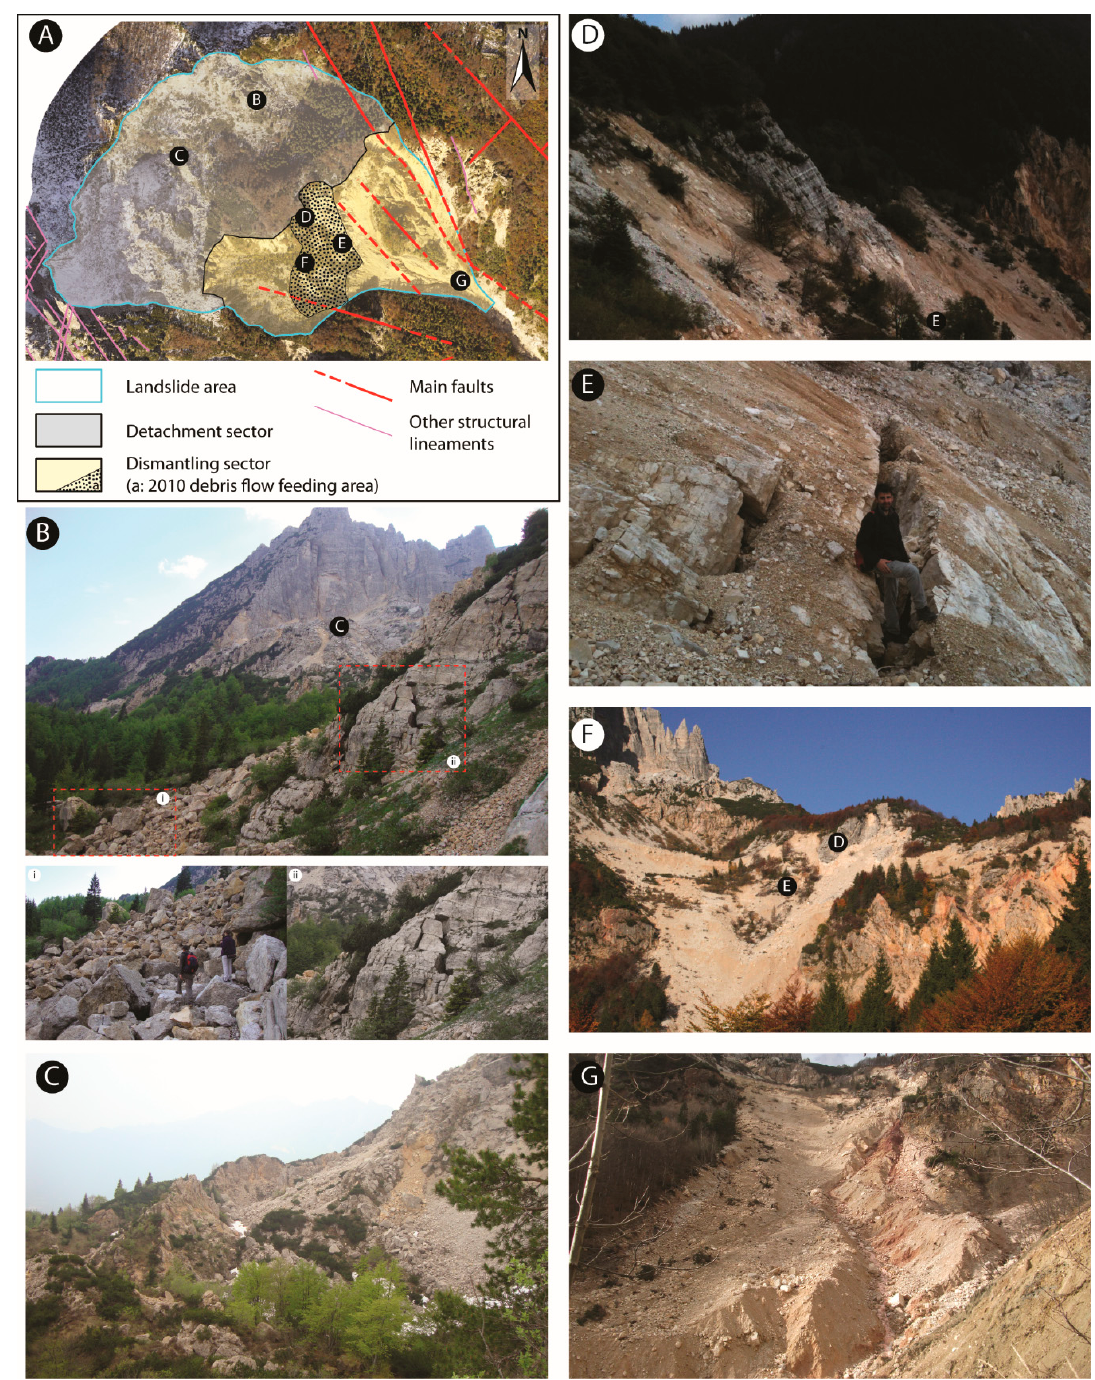
Figure 2. ( A ) The Rotolon DSGSD (modified from [15]) with the location of the main gravity landforms and short-term surface processes. The main structural lineaments are shown in red and violet. ( B ) Tensional fractures (ii) and rockfall/rock avalanche materials (i). ( C ) Trenches, crests and counterscarps. ( D ) Upper toe bulging structures and rock tilting. ( E ) Active deformation area in the bulging slope characterized by fresh and open fracturing with high angles (effect of protrusion with brittle behaviour). ( F , G ) Short-term surface processes.